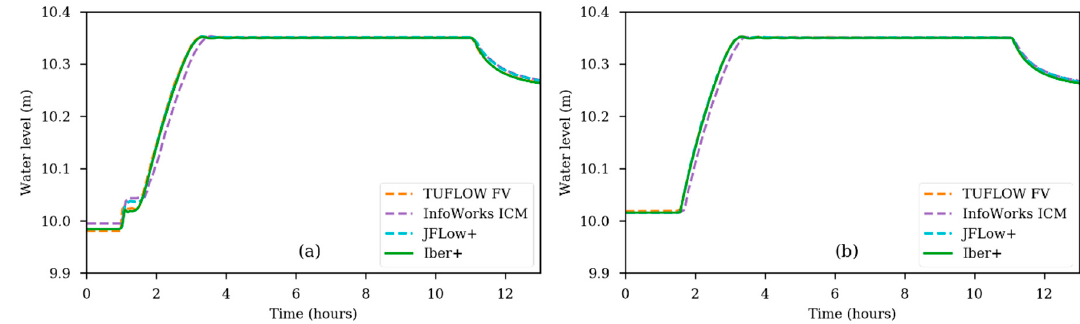
Figure 4. Time series of the water level for Test 1 obtained using all the numerical models at Point 1 ( a ) and at Point 2 ( b ).